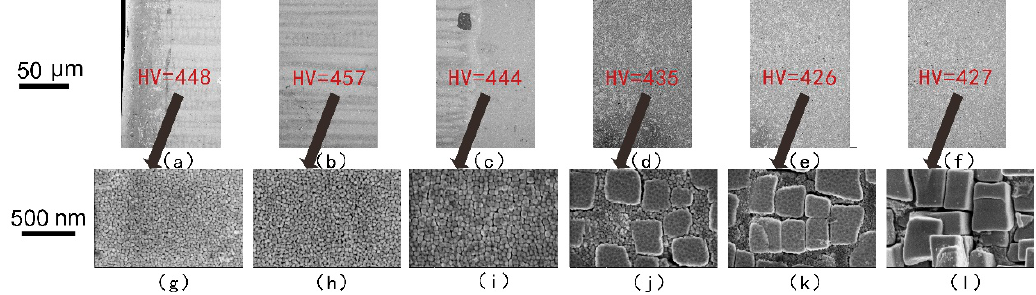
Figure 2. SEM micrographs showing the transverse section of the laser re-melted DD407 alloy in the ( a , b ) fusion zone, ( c – e ) heat-affected zone, and ( f ) substrate zone. ( g – l ) SEM images of high magnification in the center of the images above. The micro-HV data are highlighted in red.